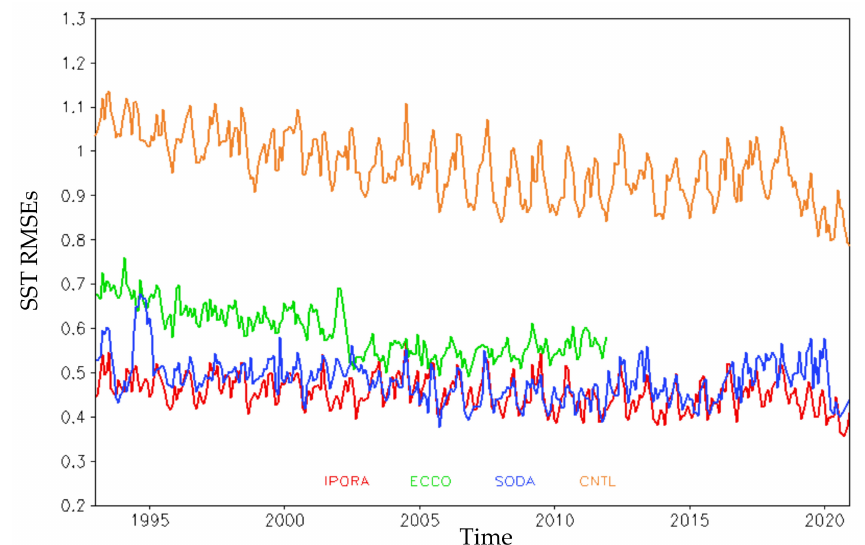
Figure 1. Time series of SST RMSEs (units: ◦ C) in the model domain from CNTL, IPORA, ECCO, and SODA for the period of